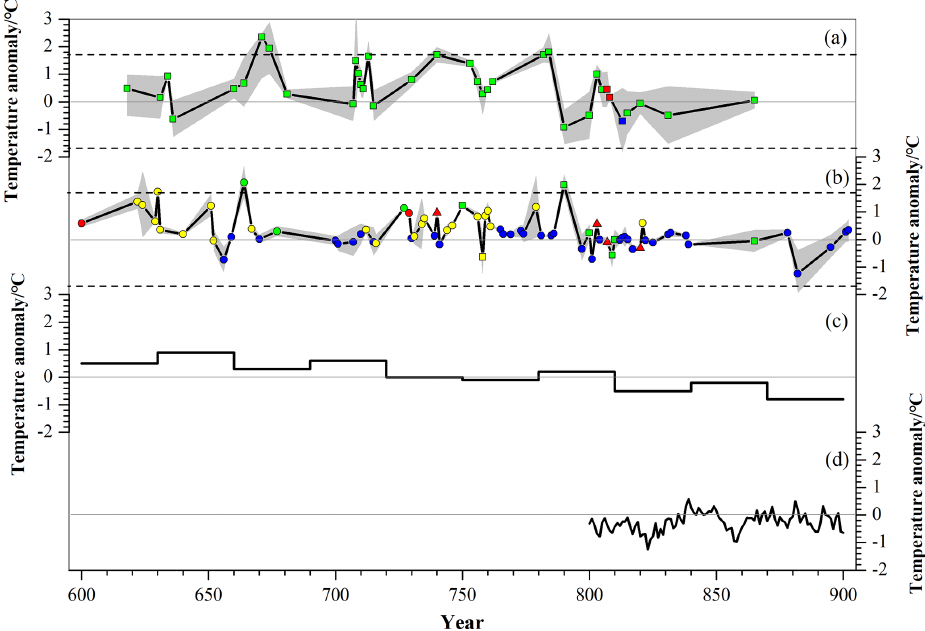
Figure 3. Comparison of reconstructed temperature anomalies for 600–900CE (with respect to the mean climatology between 1961 and 1990): (a) annual mean temperature anomalies reconstructed by phenological records from poems in this study; (b) annual mean temperature anomalies reconstructed using the phenological records from historical documents by Liu et al. (2016); (c) winter half-year temperature anomalies reconstructed from historical documents for the middle and lower reaches of the Yellow and Yangtze Rivers with a 30-year tempo- ral resolution by Ge et al. (2003); and (d) annual mean temperature reconstructed from tree rings for the whole of Asia by Ahmed et al. (2013). Squares denote temperature anomalies reconstructed from poems, circles denote temperature anomalies reconstructed from documents of institutions, triangles denote temperature anomalies reconstructed from both poems and documents of institutions, green denotes temperature anomalies reconstructed by phenophases of wild plants, yellow denotes temperature anomalies reconstructed by agricultural phenophases, blue denotes temperature anomalies reconstructed by non-organic phenophases, red denotes temperature anomalies reconstructed by at least two types of phenophases, the gray area approximates the 95% confidence interval according to ordinary least-squares (OLS) regression, and the dotted lines indicate the 2 standard deviation range of 1.72 ◦ C of the modern period (1951–2013). Table 6. Comparisons of data sources, types, and numbers of records used in Liu et al. (2016) and in this study. Liu et al. (2016) This study Documents of institutions Poems Total